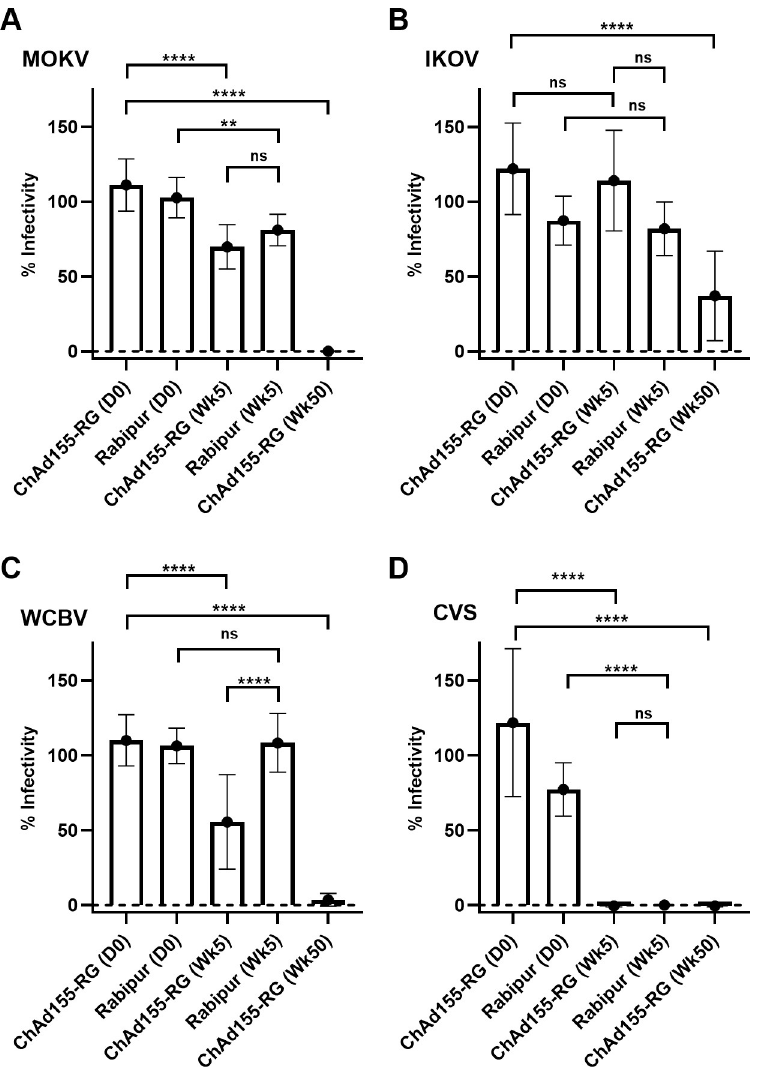
Fig 8. Neutralization of pseudoviruses harboring phylogroup II and III lyssavirus glycoproteins. Immune sera obtained 5 weeks following immunization of NHPs with either RABIPUR or ChAd155-RG, and at week 50 following a ChAd155-RG boost were tested for their ability to neutralize pseudoviruses harboring either MOKV (A), IKOV (B), WCBV (C) or control classical CSV-11 (D) glycoproteins. Data represent the mean and standard deviation of combined normalized values for two replicate experiments, with each replicate experiment containing three technical replicates, and where 100% infectivity was set at the mean infectivity (measured in relative light units) observed in the absence of